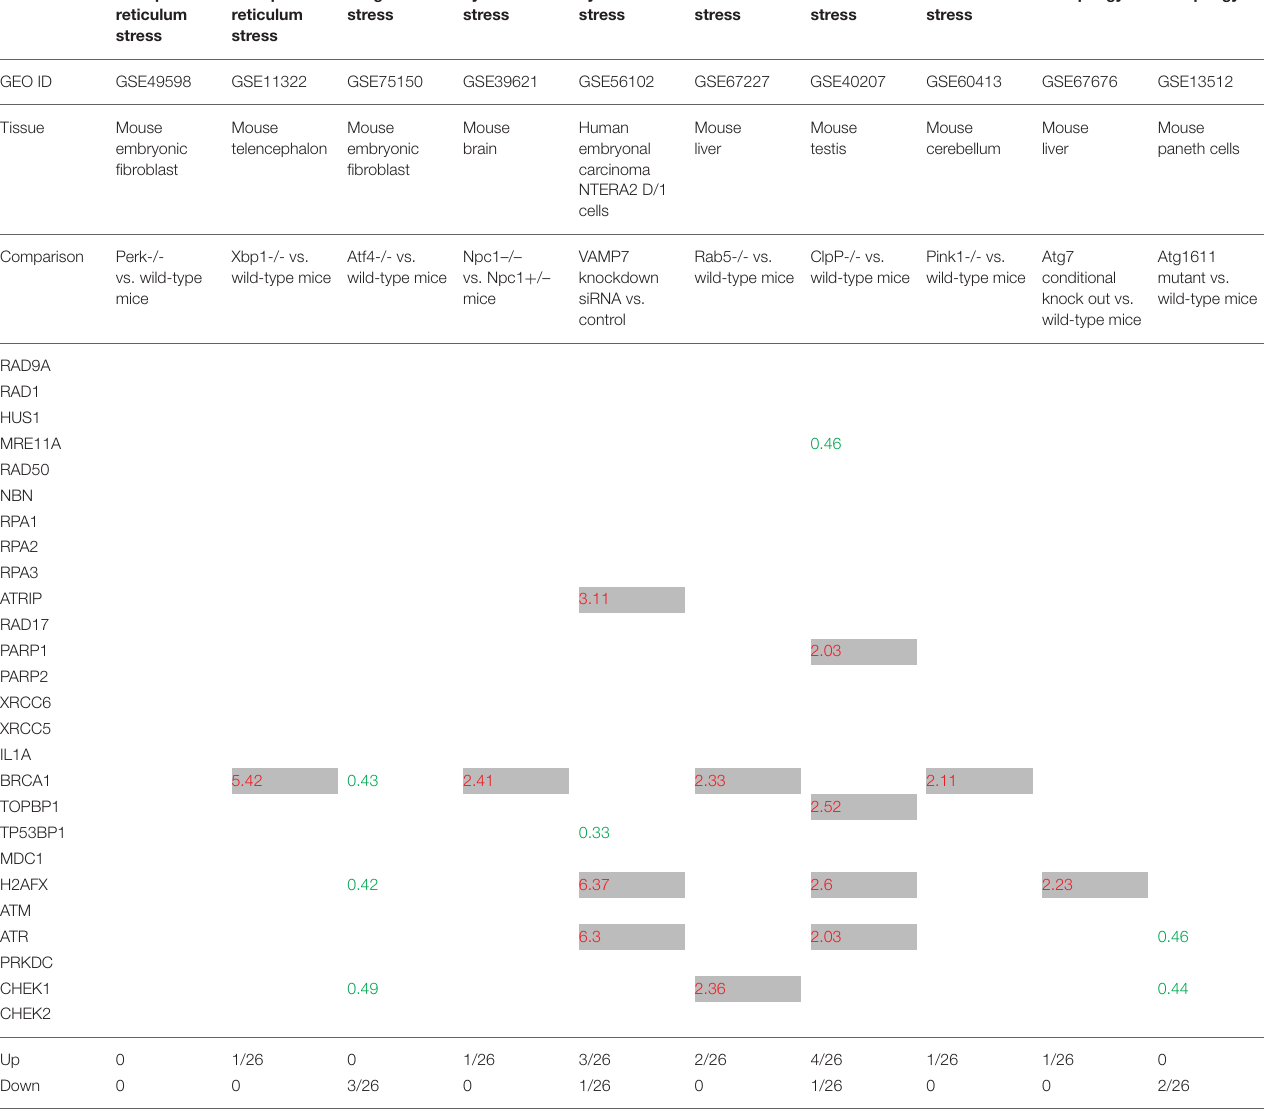
TABLE 2 | The gene expression changes of DNA damage checkpoint factors in response to intracellular organelle stress. Endoplasmic